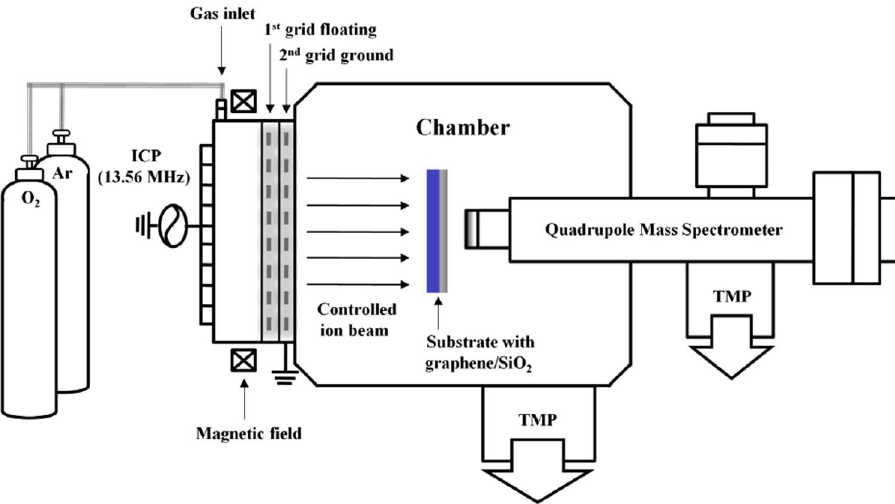
Figure 1. Schematic diagram. A two-grid ICP-type ion beam system with axial magnetic field used for graphene ALE and a quadrupole mass spectrometer for ion energy/flux measurement of the ion